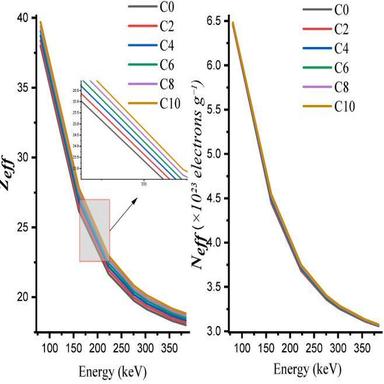
Variation of effective atomic number and electron density (Zeff and Neff) against photon energy for the glasses.